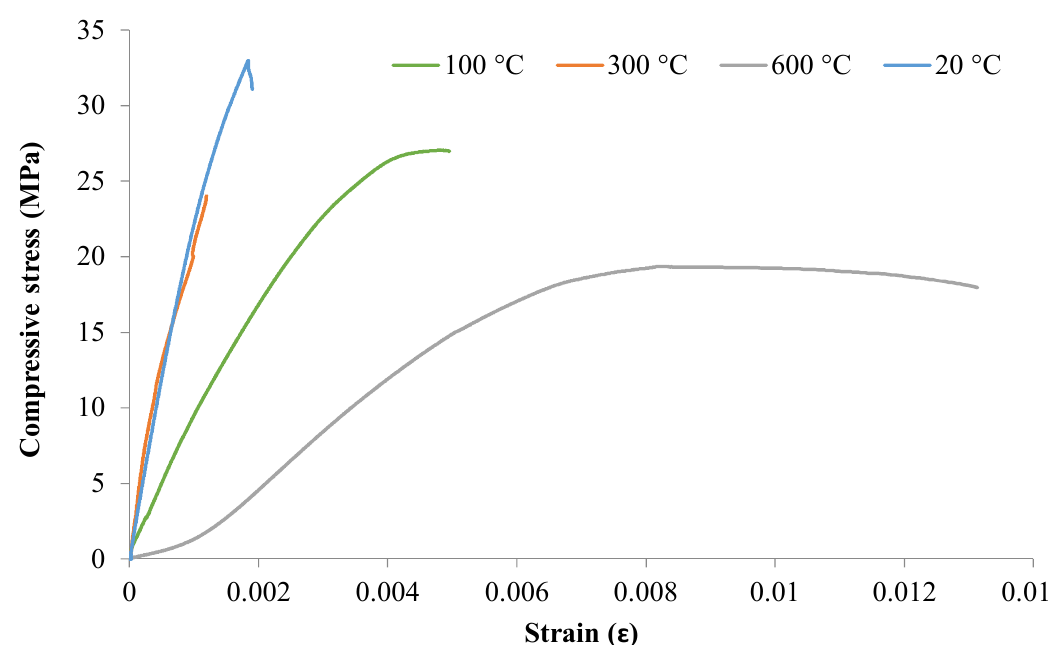
Figure 10. Compressive stress–strain curves for M3 after 28-days at high temperatures.